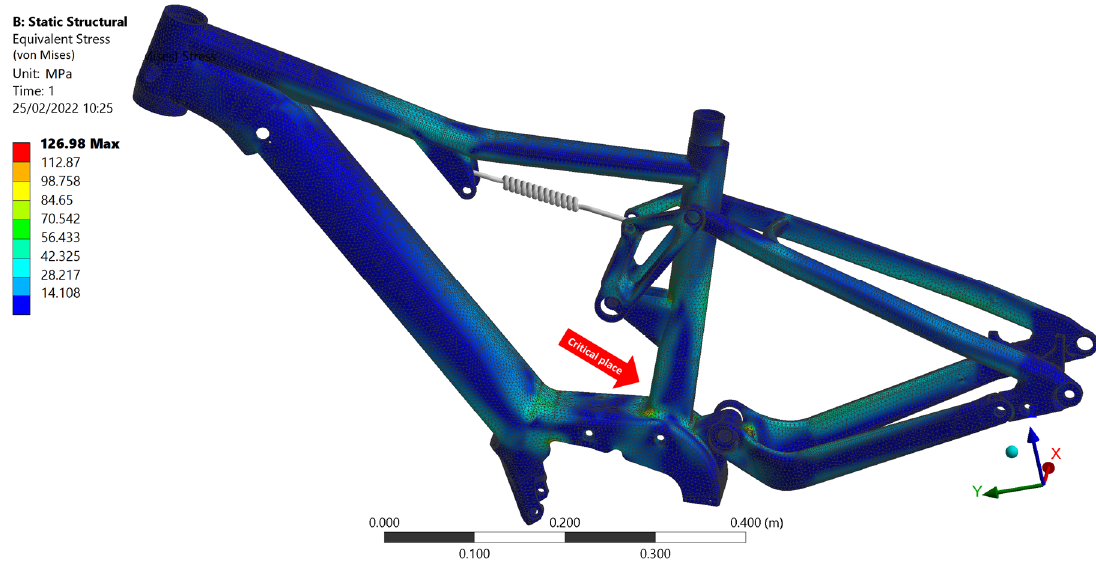
Figure 5. FEM model with the critical place of the structure.